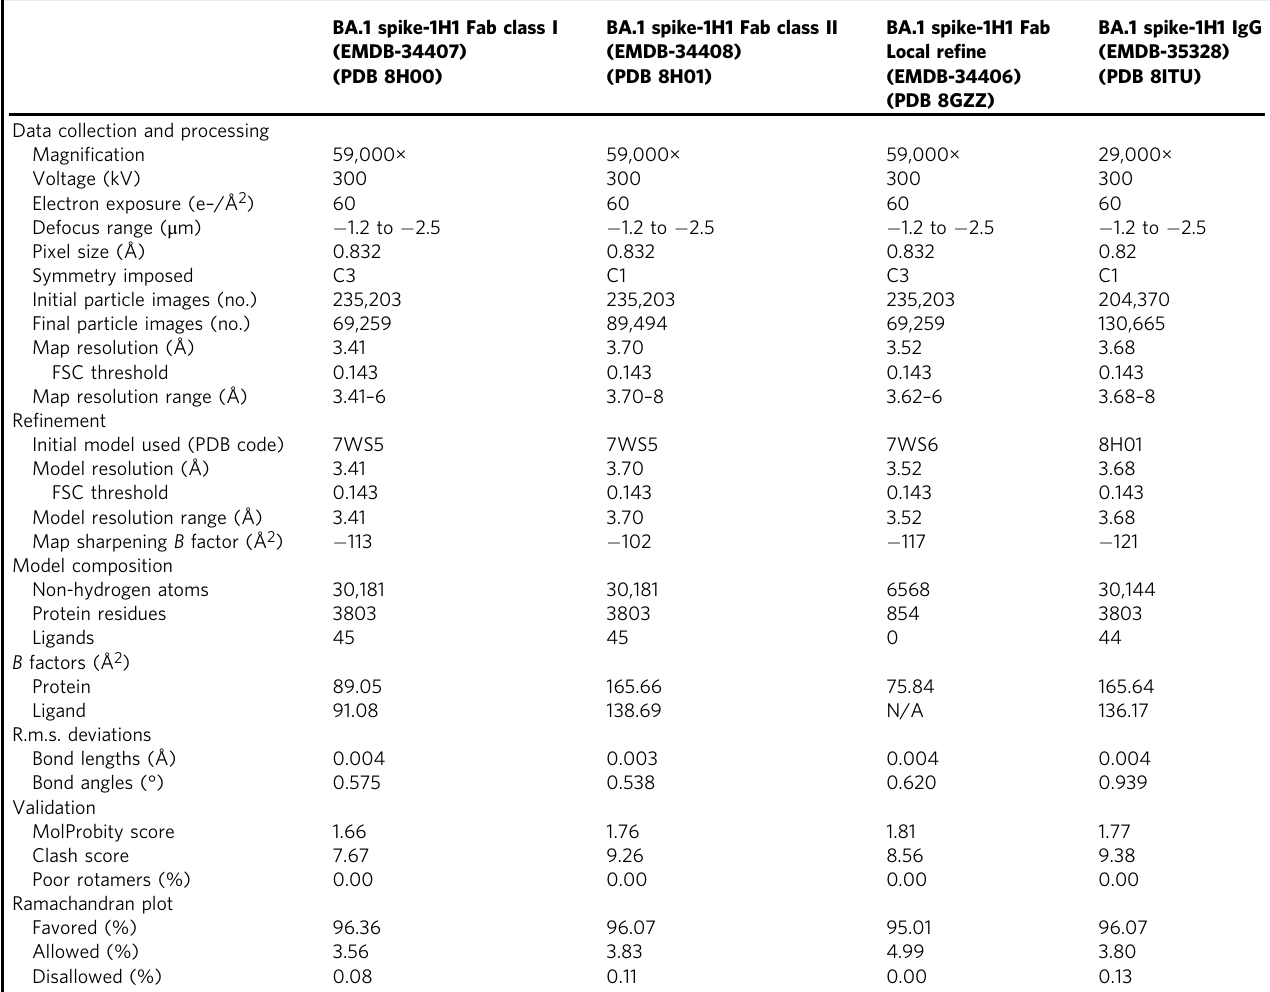
Table 1 Cryo-EM data collection, re fi nement and validation